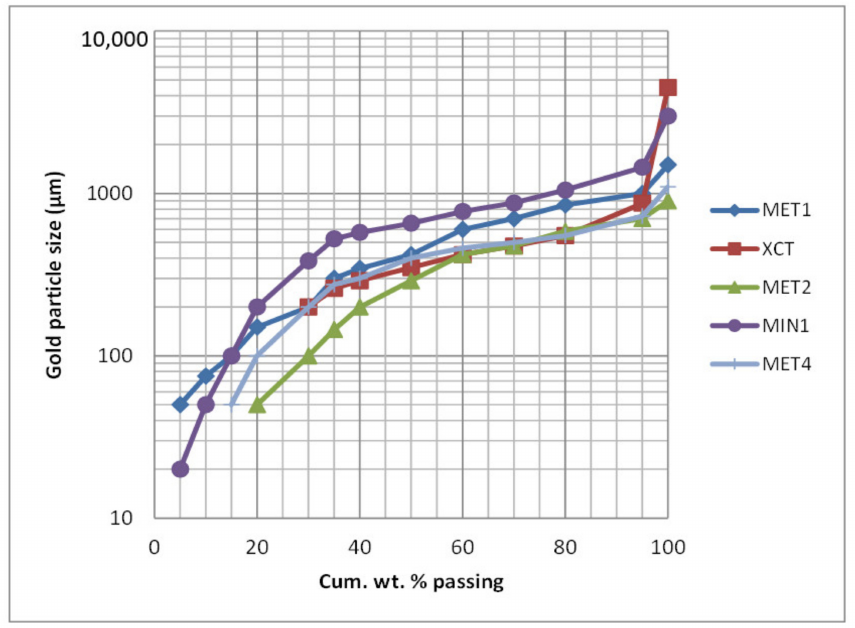
Figure 14. Gold particle size curves for high-grade LV material. Results plotted: MET1; MET2; MET4; MIN1 and XCT.